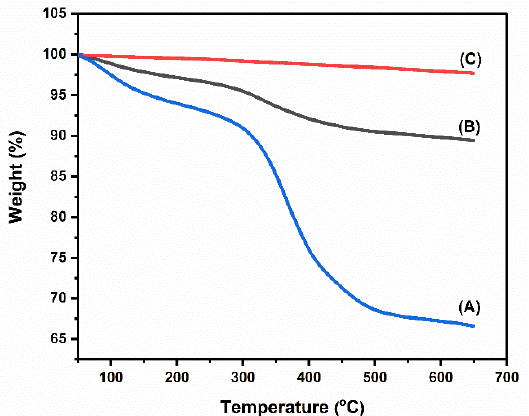
Figure 4. Thermogravimetric analysis of (A) raw fish bone, (B) alkali-treated nano HA, and (C) ther- thermally calcined nano mally calcined nano HA.